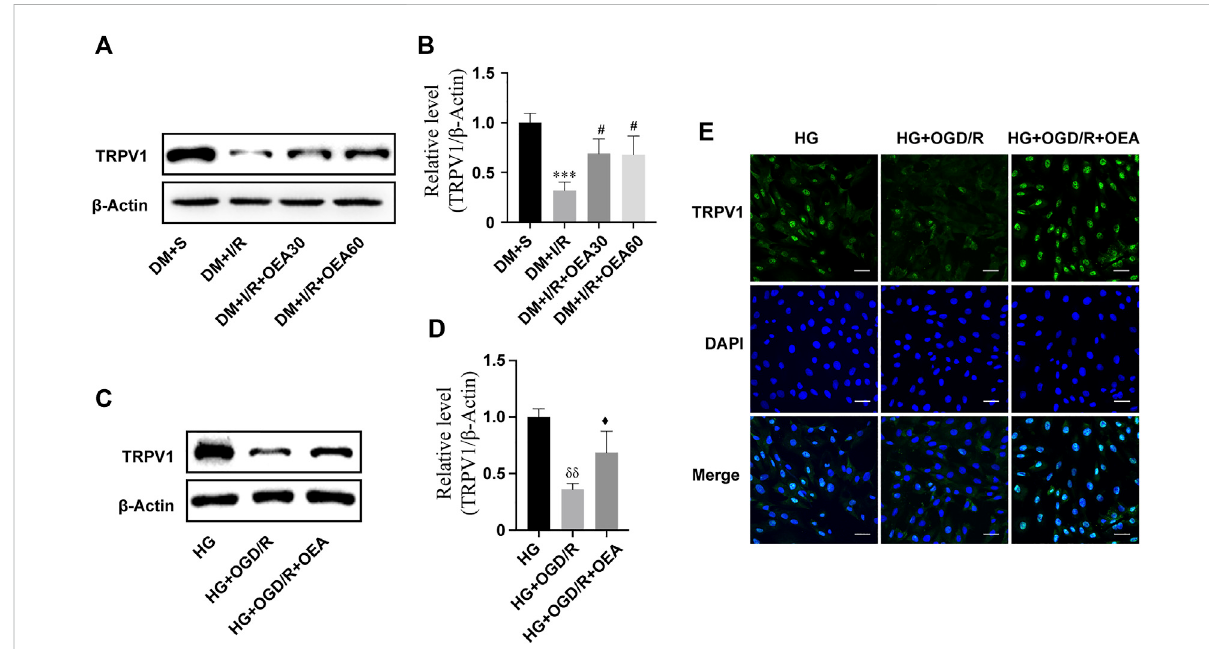
The expression level of TRPV1 was upregulated after OEA treatment. (A,B) Semi-quantitative analysis revealed that OEA pretreatment reduced the expression level of TRPV1 protein in diabetic myocardial ischemia-reperfusion injury rats. (C,D) Semi-quantitative analysis indicated that OEA pretreatment decreased the expression level of TRPV1 protein in H9C2 cells. (E) IF results showed immuno fl uorescence staining of cells in each group with DAPI fl uorescent-labeled dye (nucleus, blue) and TRPV1 (green), scale = 50 μ m. Data were expressed as mean ± SEM, *** p